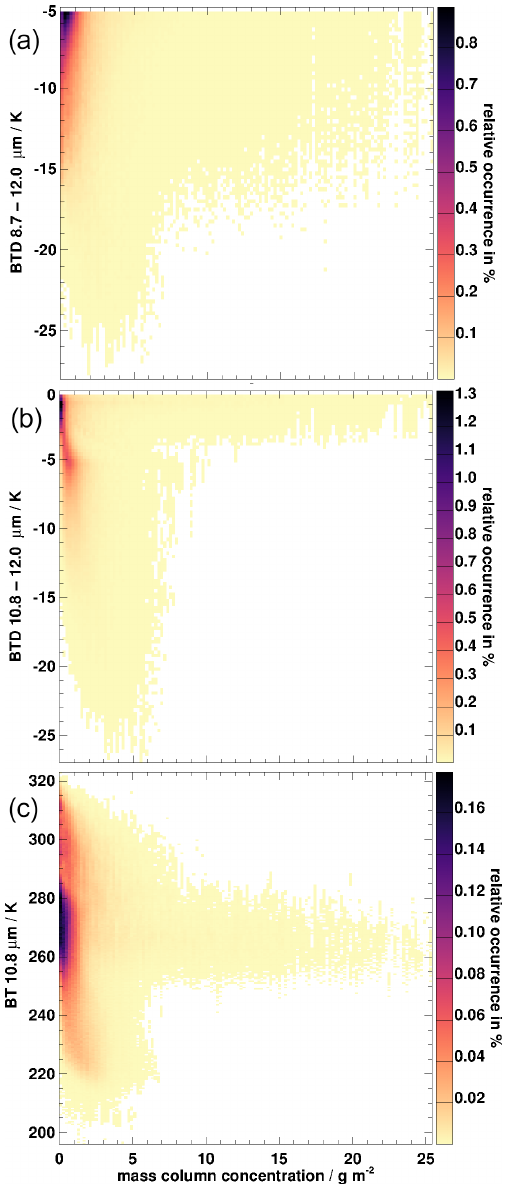
Figure 2. Histogram of (a) BTD(8.7–12.0), (b) BTD(10.8–12.0) and (c) BT(10.8) for ash-contaminated simulations as a function of